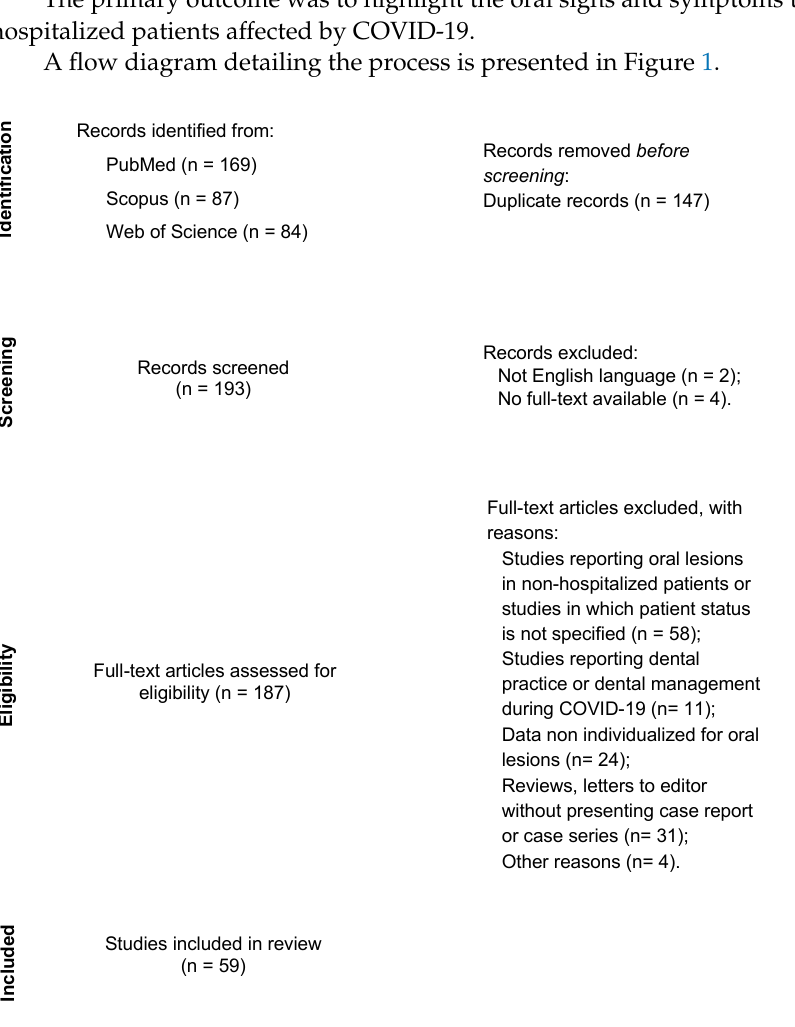
Figure 1. Flow diagram of literature search and selection criteria adapted from PRISMA (Preferred Reporting Items for Systematic Reviews and Meta-Analyses).